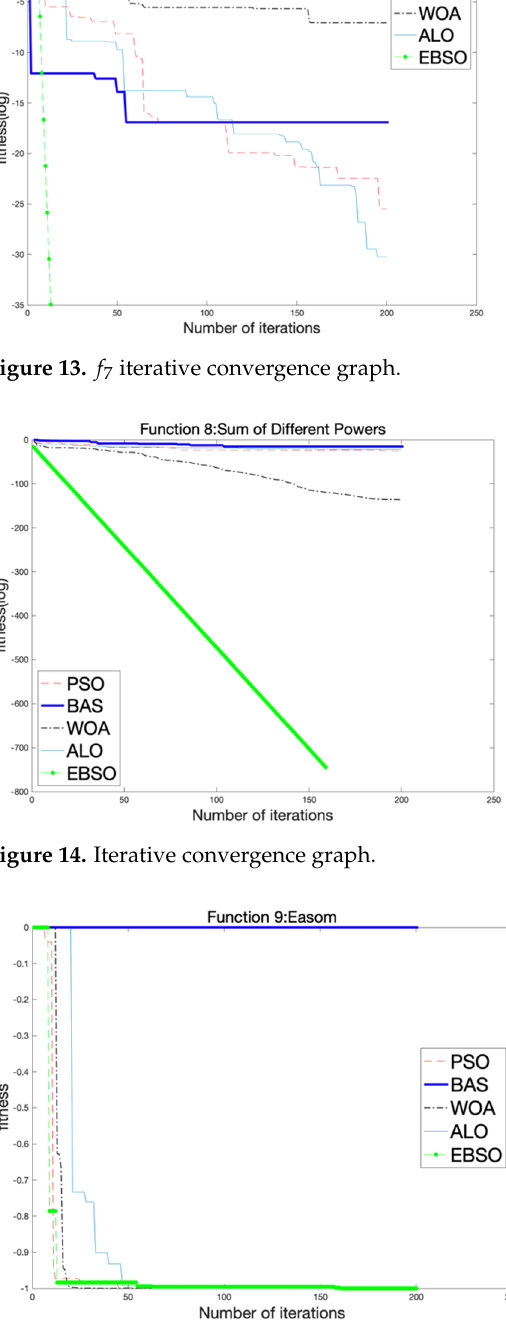
Figure 15. Iterative convergence graph.